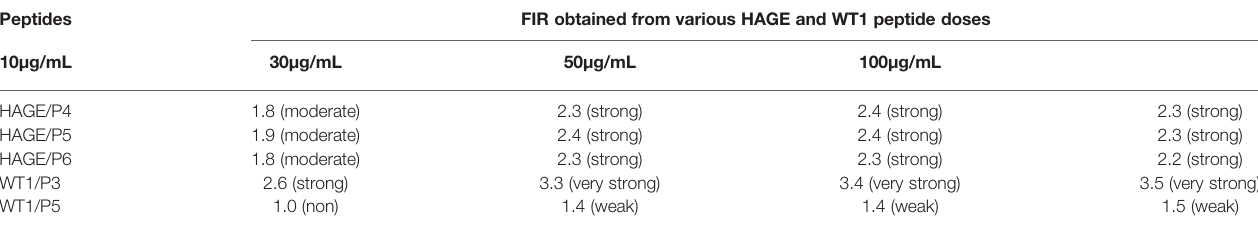
TABLE 3 | Categorisation of the binding af fi nity of class I HAGE- and WT1-derived peptides toward HLA-A2 molecules, as assessed using the T2 binding assay. Peptides FIR obtained from various HAGE and WT1 peptide doses 10µg/mL 30µg/mL 50µg/mL 100µg/mL HAGE/P4